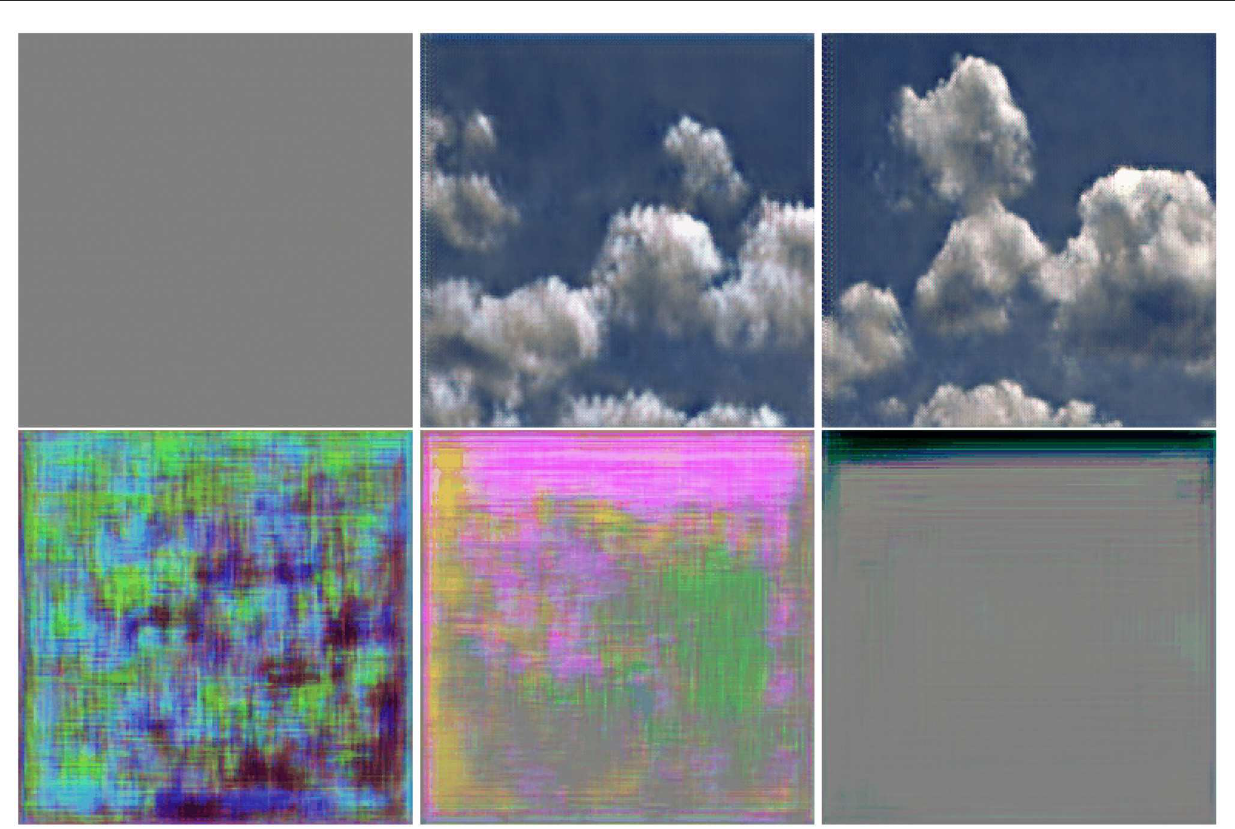
FIGURE8 Images generated after 0, 1,000, and 2,000 epochs (columns from left to right , respectively) using T_DCGAN (top) and R_DCGAN (bottom) variants of DCGAN. As shown in Figure 9, R_DCGAN outperforms T_DCGAN at the beginning of training (up until approximately 800 epochs).